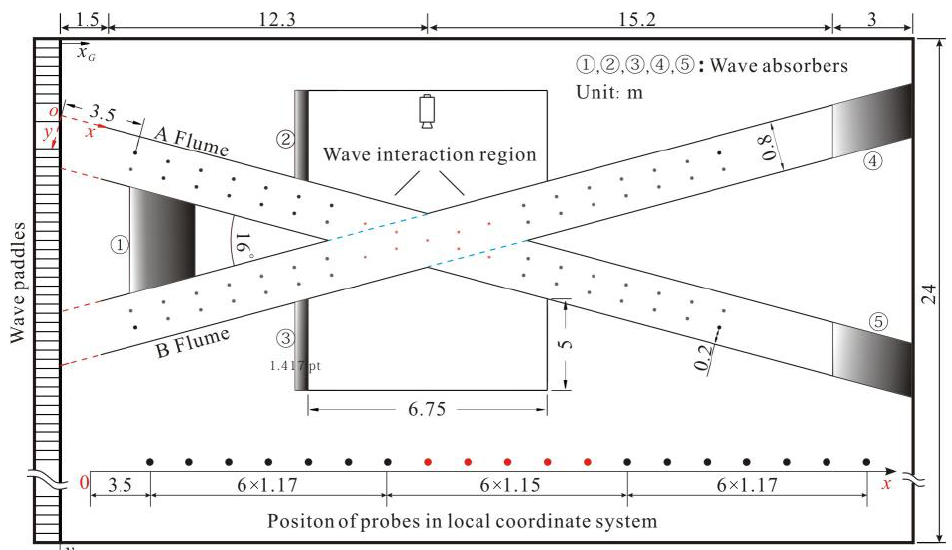
Figure 1. Experimental setup. (Not to